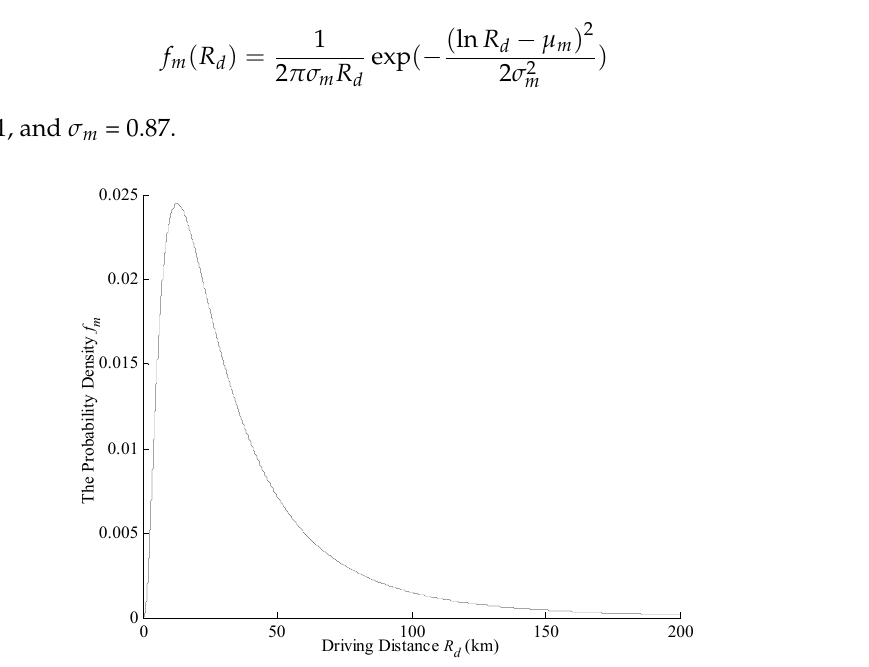
Figure 1. Distribution of the time of EVs to be connected to and disconnected from the grid.